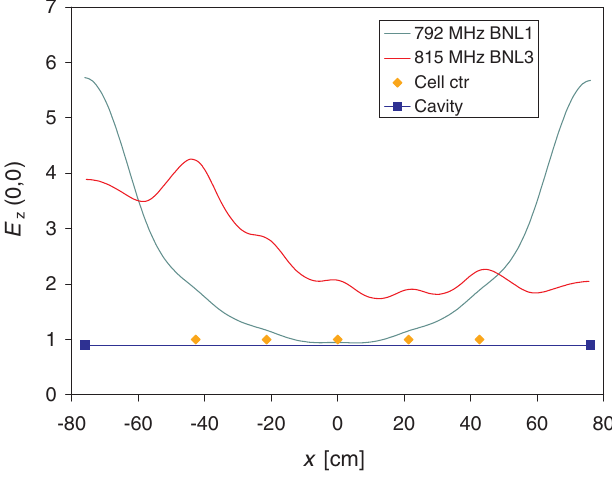
FIG. 13. On-axis transverse electric field of the 0 (cid:1)= 5 modes in BNL1 and BNL3. The fields are plotted against the location of the cell centers.